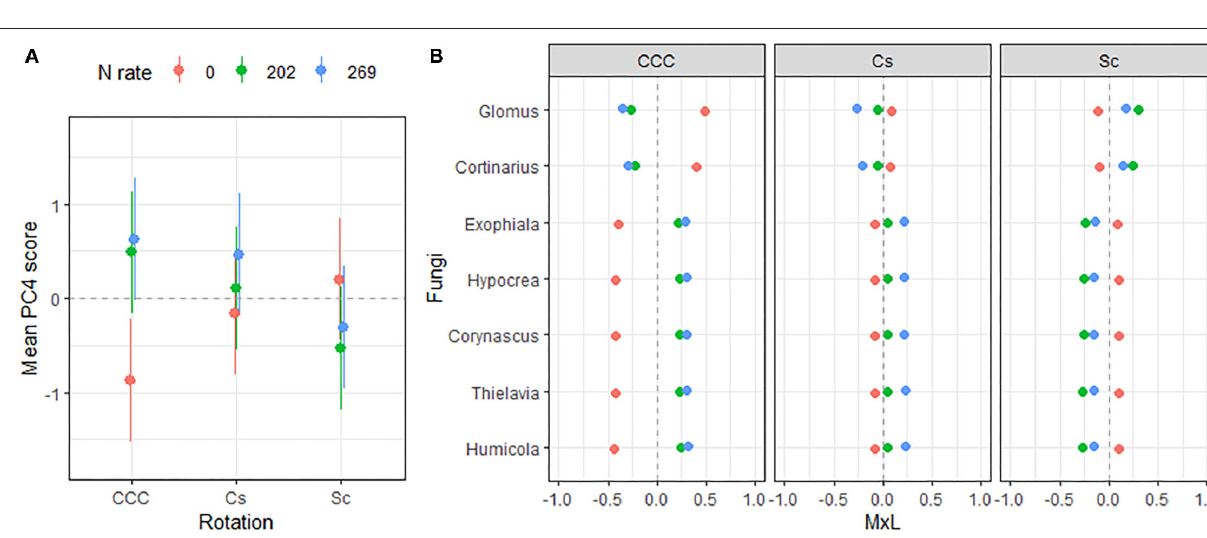
signature of the continuous corn management when compared to the rotated systems ( Figure 1